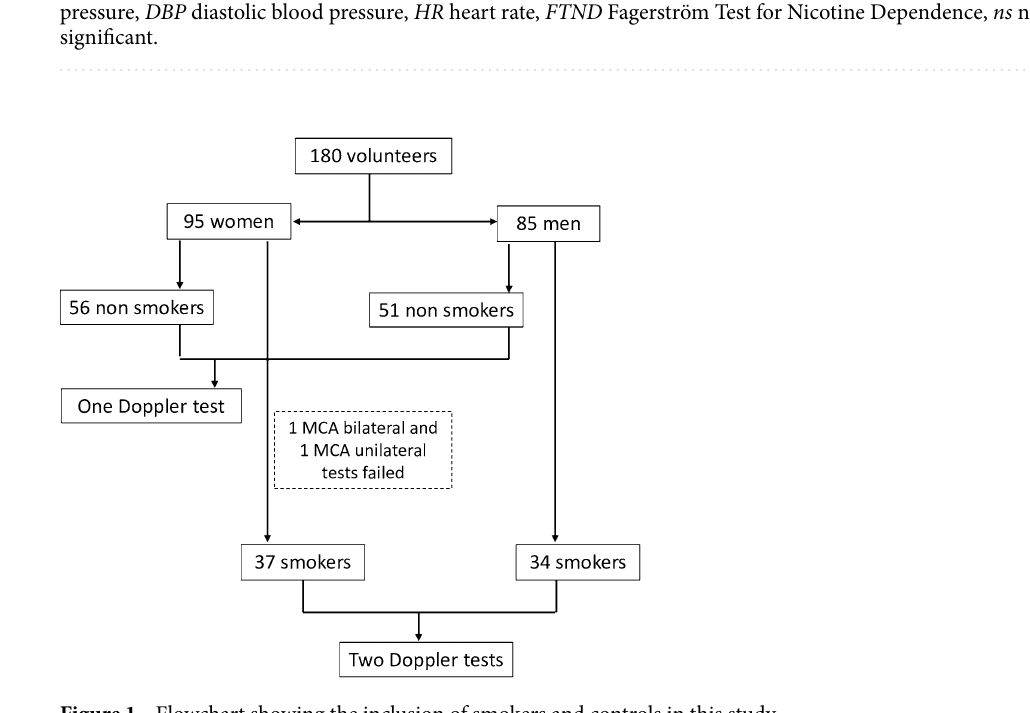
Table 1. Comparison between clinical variables and patterns of cigarette consumption observed between men and women smokers and non-smokers groups. CG control group, SG smokers group, SBP systolic blood